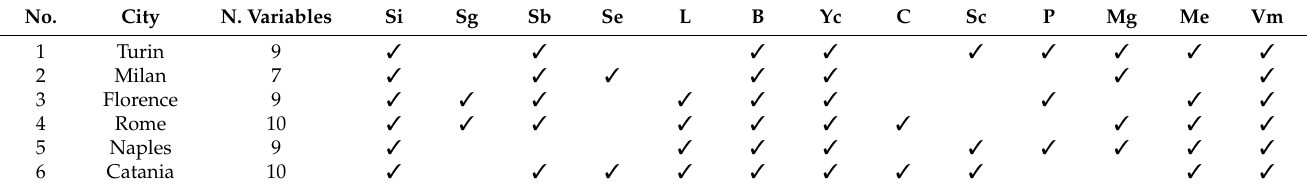
Table 5. Variables selected by the models generated by EPR-MOGA for each study sample of Phase I.